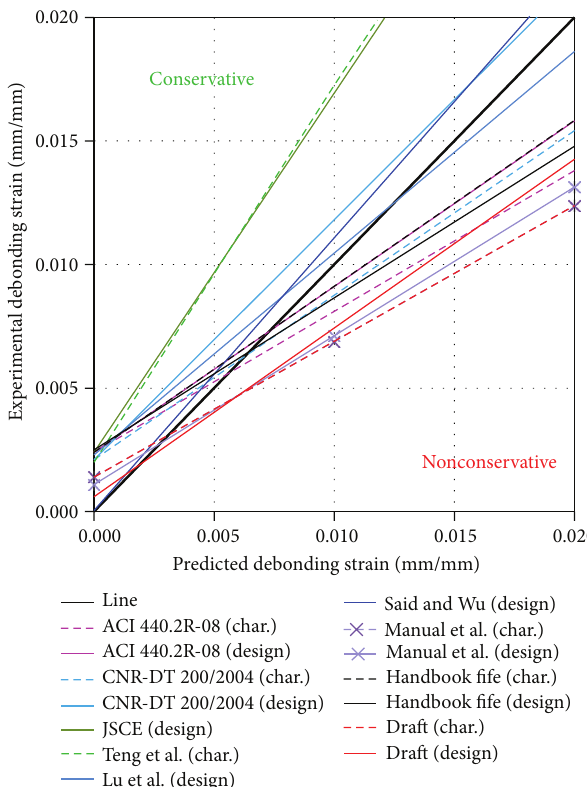
Figure 1: Experimental versus theoretical debonding